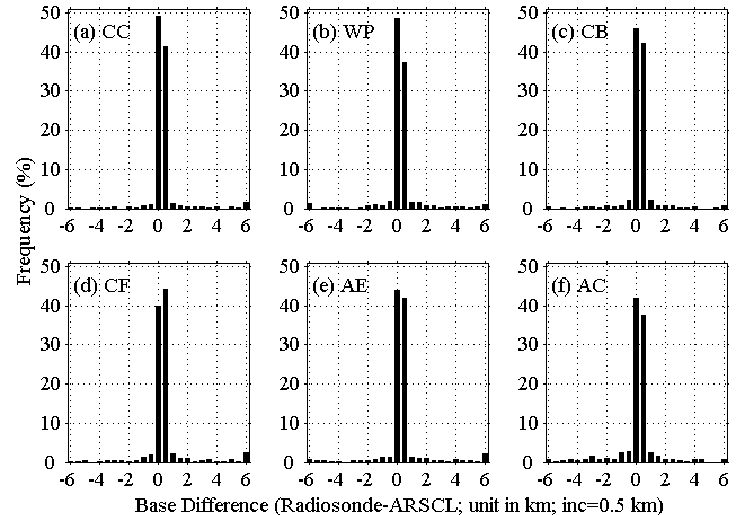
Figure 8. Histogram of difference of collocated cloud-base heights derived from the radiosonde and